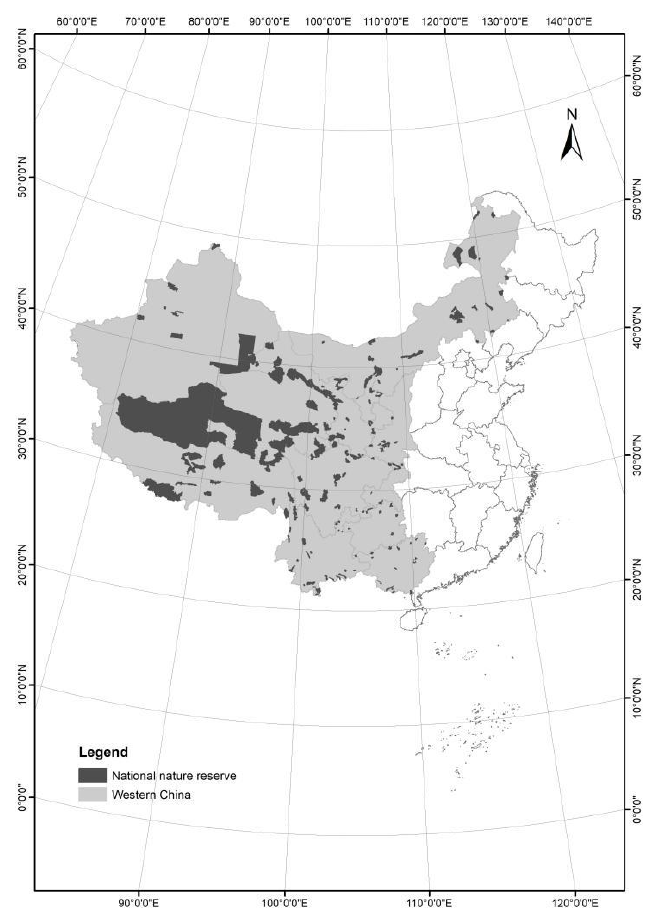
Figure 1. Location of the study area in China.